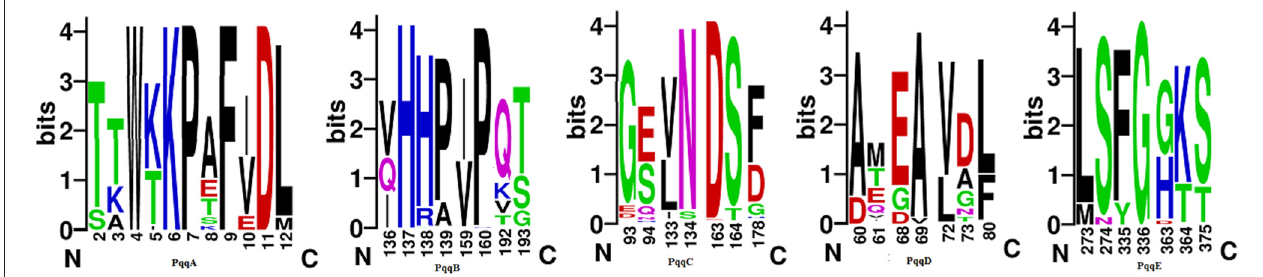
FIGURE 3 | Semi-conservative sites of PqqA–PqqE proteins. Notes: The conserved sites generated from the MSA of all the identified pqq A– pqq E proteins from different species, subspecies, and strains of Klebsiella , Enterobacter , Pantoea , Nissabacte r, Erwinia , Kosakonia , Rahnella , Mixta , Cronobacter , Rouxiella , and Serratia , respectively, were represented in sequence logos based on the alignment of full-length sequences of all the Pqq proteins and their homologous sequences. The overall height of each stack indicates the conservation of the sequence at the corresponding location, while the height of the letters within each stack indicates the relative frequency of the corresponding amino acid. All conserved site-wise analyses have been represented in Supplementary Table 2